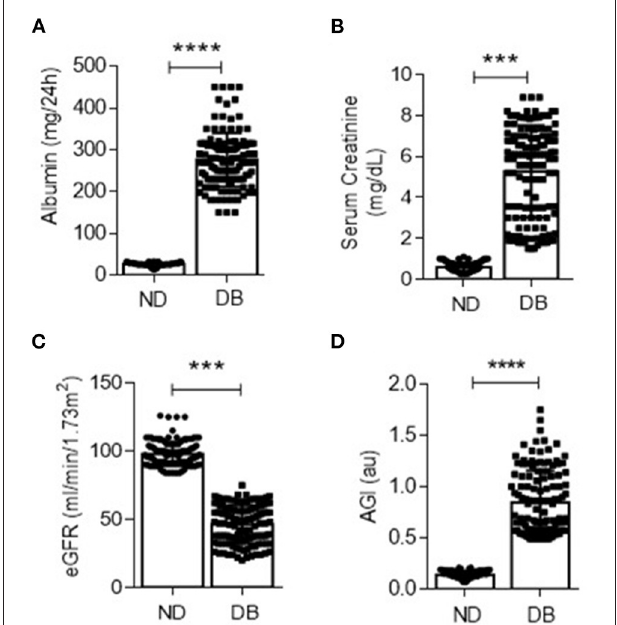
FIGURE 1 | Urinary albumin (A) and serum creatinine (B) were quantified in non-diabetic (ND) and diabetic (DB) groups. *** p < 0.001 and **** p < 0.0001. (C) The estimated glomerular filtration rate (eGFR) was measured in ND and DB groups. *** p < 0.001, n = 130 in both the groups. (D) Advanced glycation index (AGI) was measured in ND and DB as described in methods. **** p < 0.001, n = 130 in each group. Data are the mean ± SD, and statistical significance is calculated by using the student t